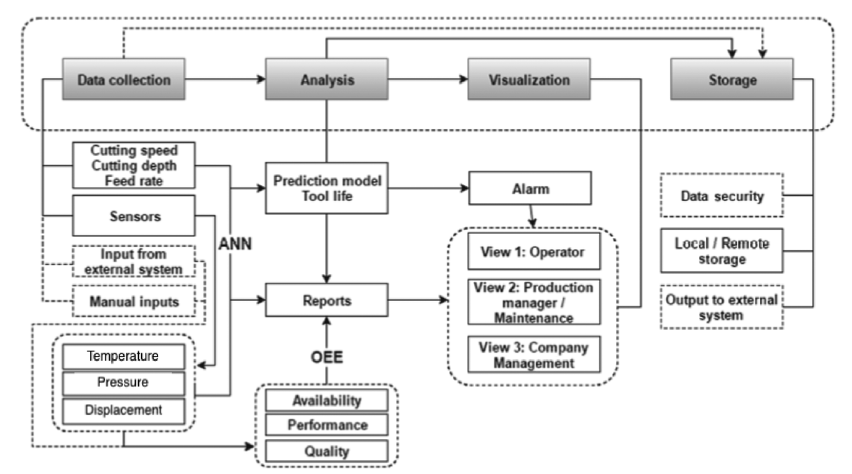
Fig. 2. Concept of the production monitoring system